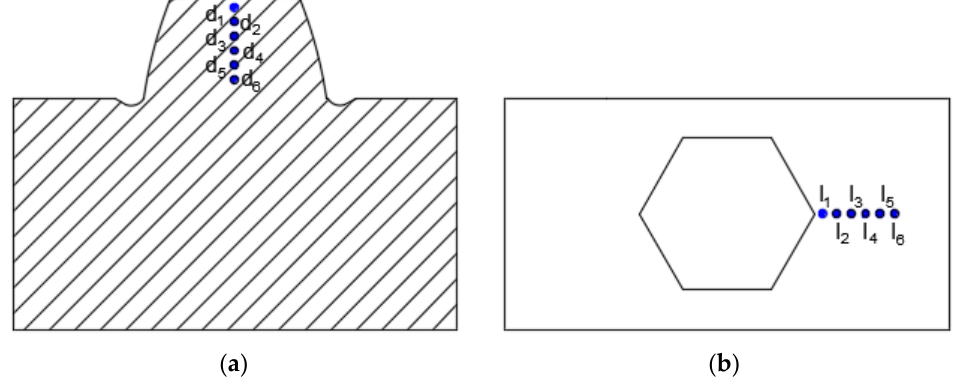
Figure 8. Diagram of point selection. ( a ) Depth Direction; ( b ) Horizontal direction.